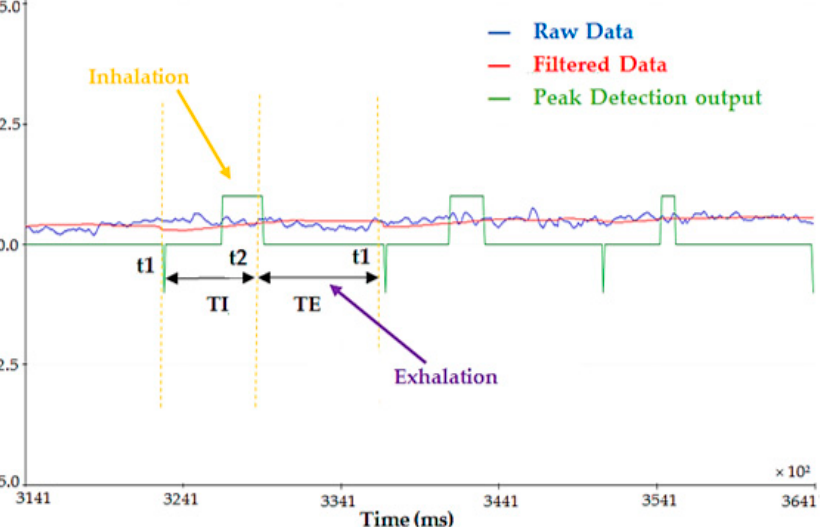
Figure 8. Plot depicting the raw (blue trace) and filtered (red trace) acceleration signals, along with the output of the peak detection algorithm (green trace) based on the dispersion